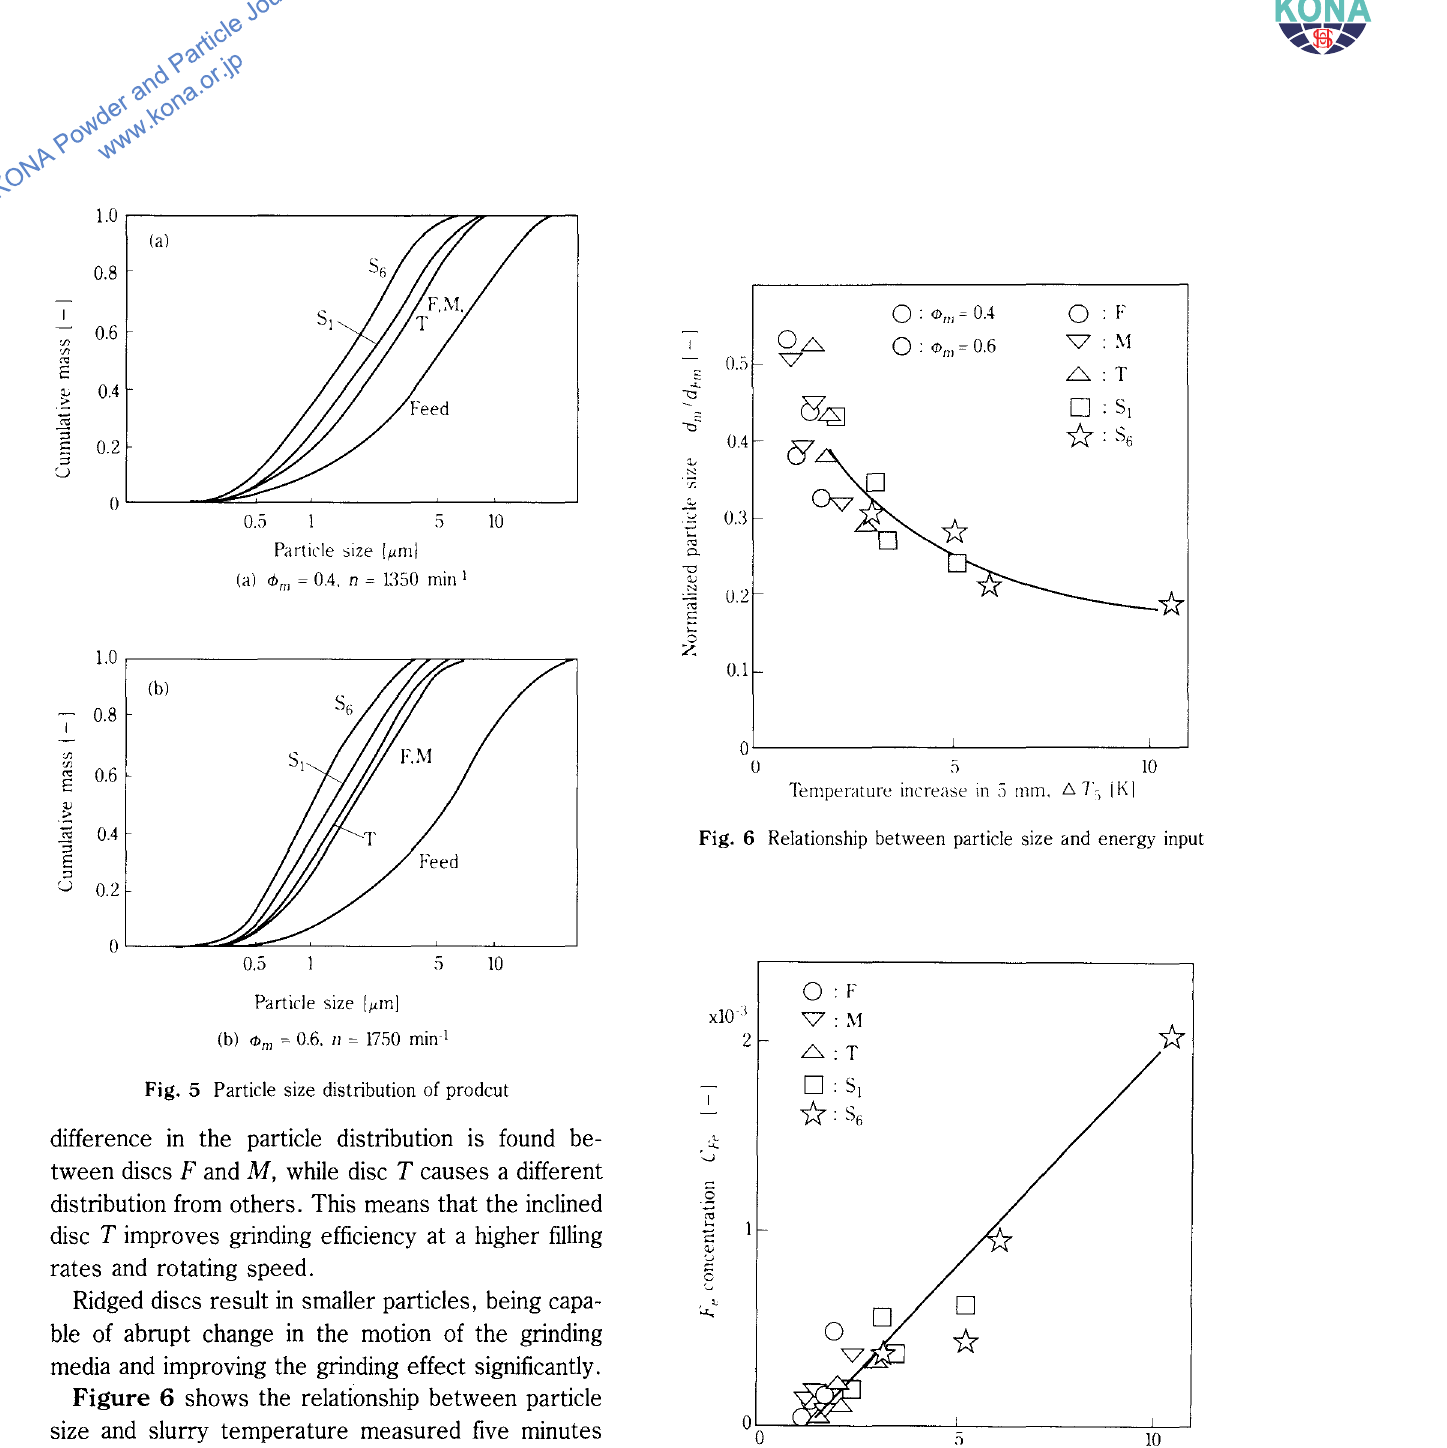
Fig. 5 Particle size distribution of prodcut